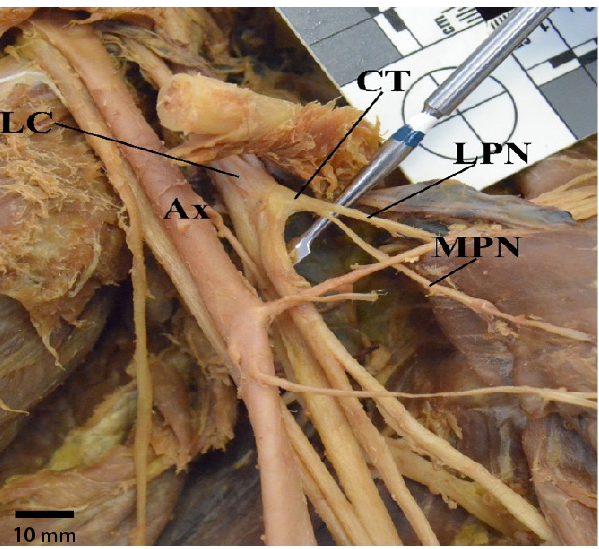
Figure 10. Photograph showing an example of a medial pectoral nerve sharing a common trunk with lateral pectoral nerve. Abbreviations: Ax = axillary artery; CT = common trunk; LC = lateral cord; LPN = lateral pectoral nerve; MPN = medial pectoral nerve.